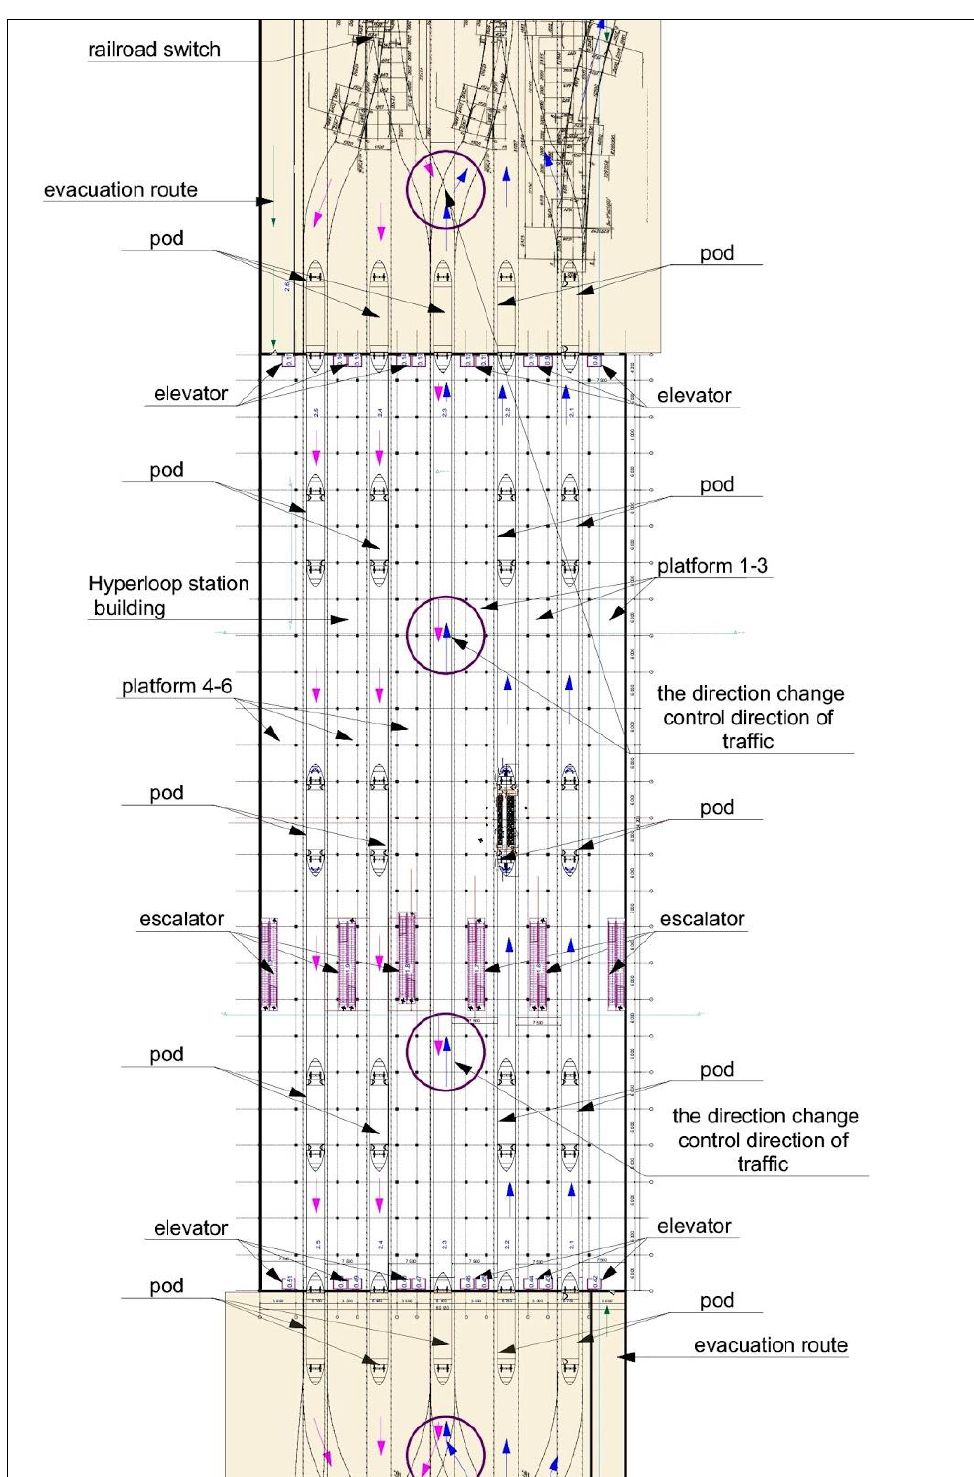
Figure 7. Detailed presentation of turnouts in the technical zone.